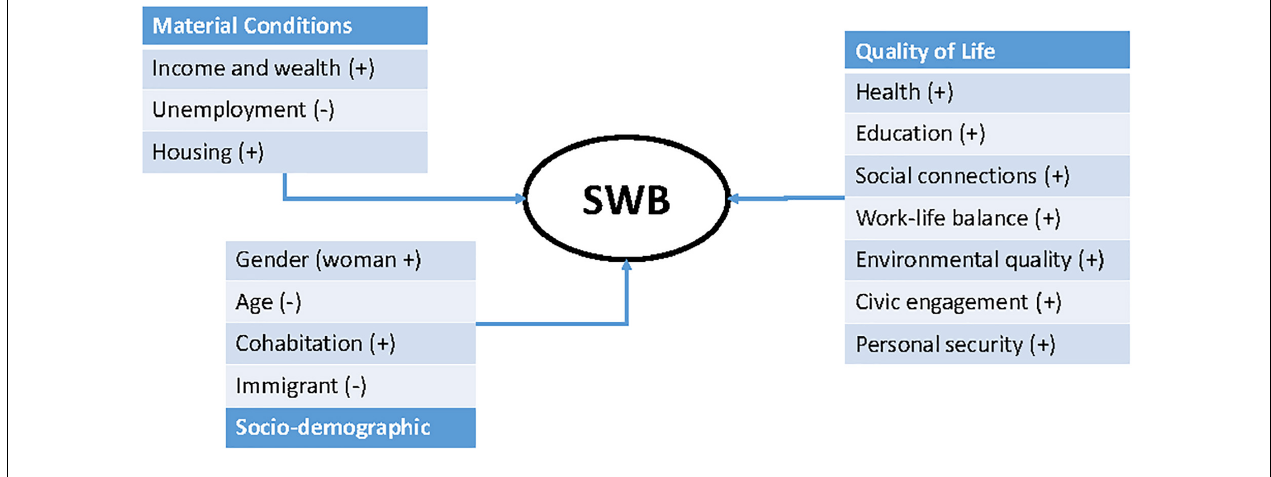
FIGURE 1 | Main drivers of